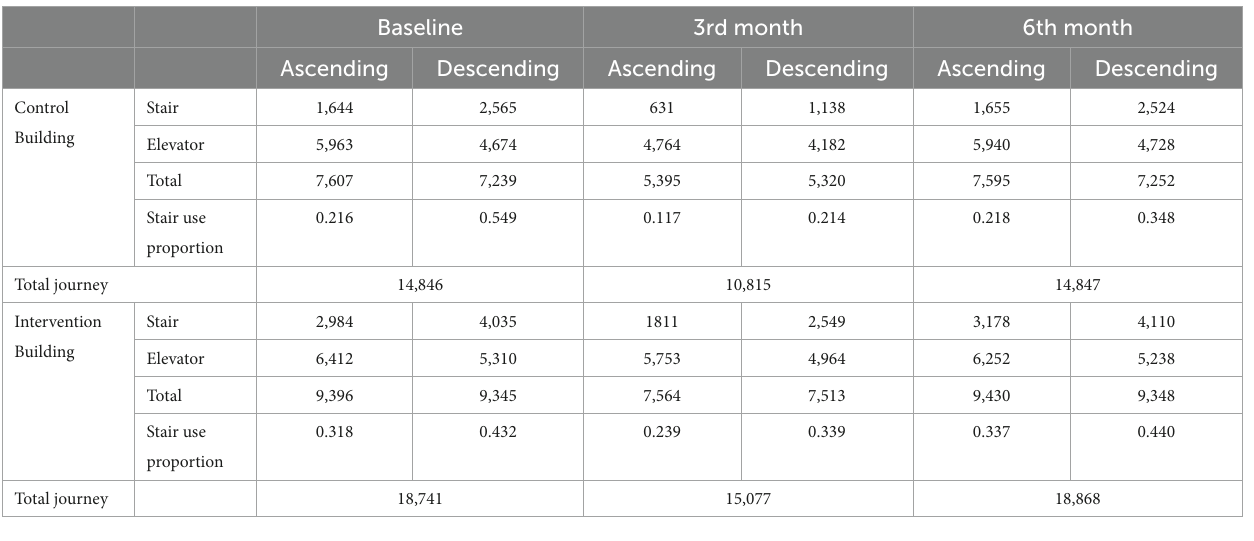
TABLE 3 Stair and elevator